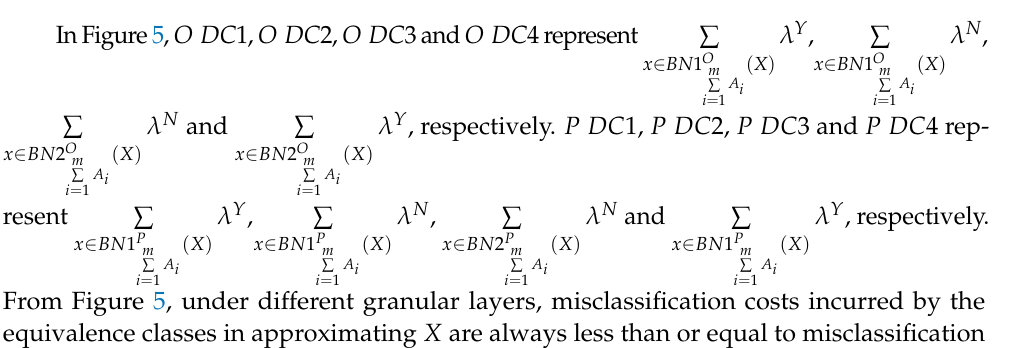
Figure 4. The misclassification cost with the changing granularity on each